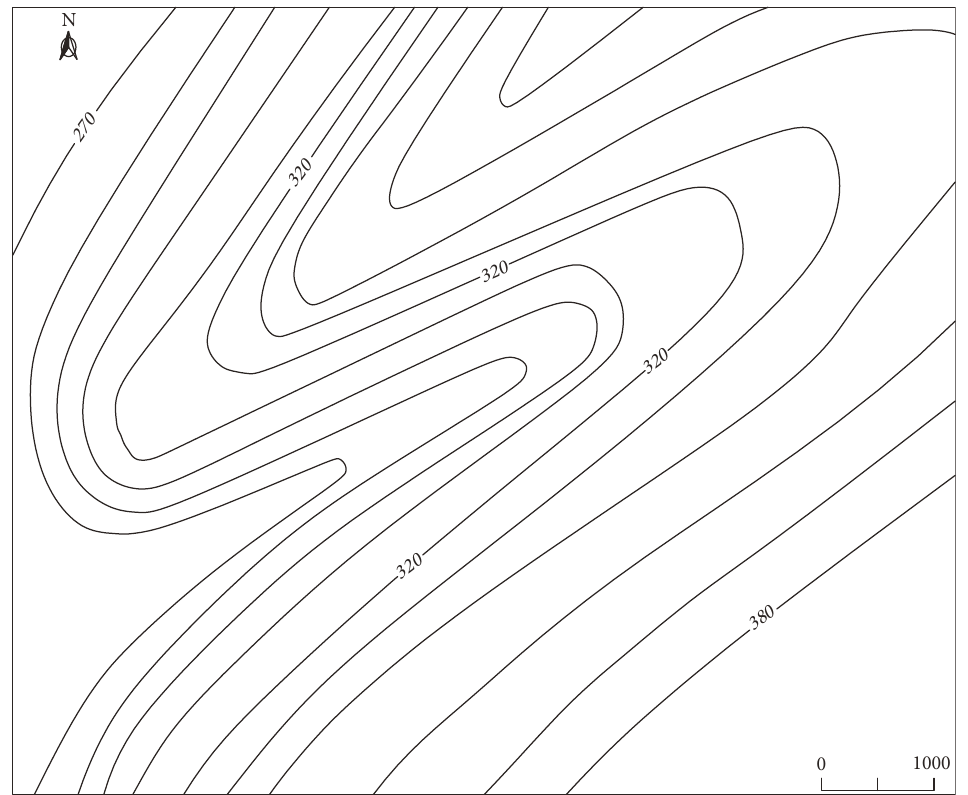
Figure 8: The structural features of the coal seam at key moments in the Yanshanian